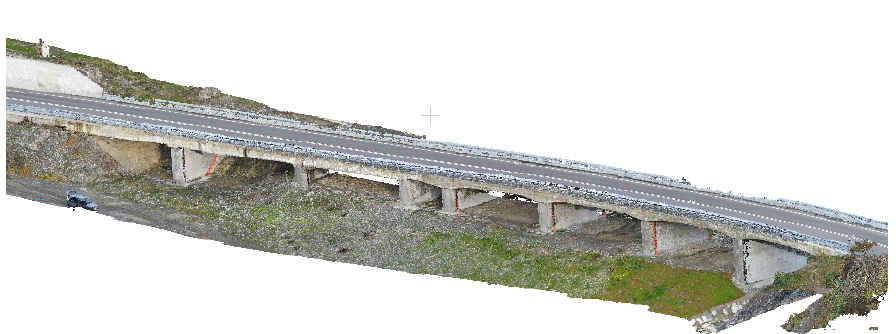
Figure 8. Overview of the inspection path planner processing method [46].